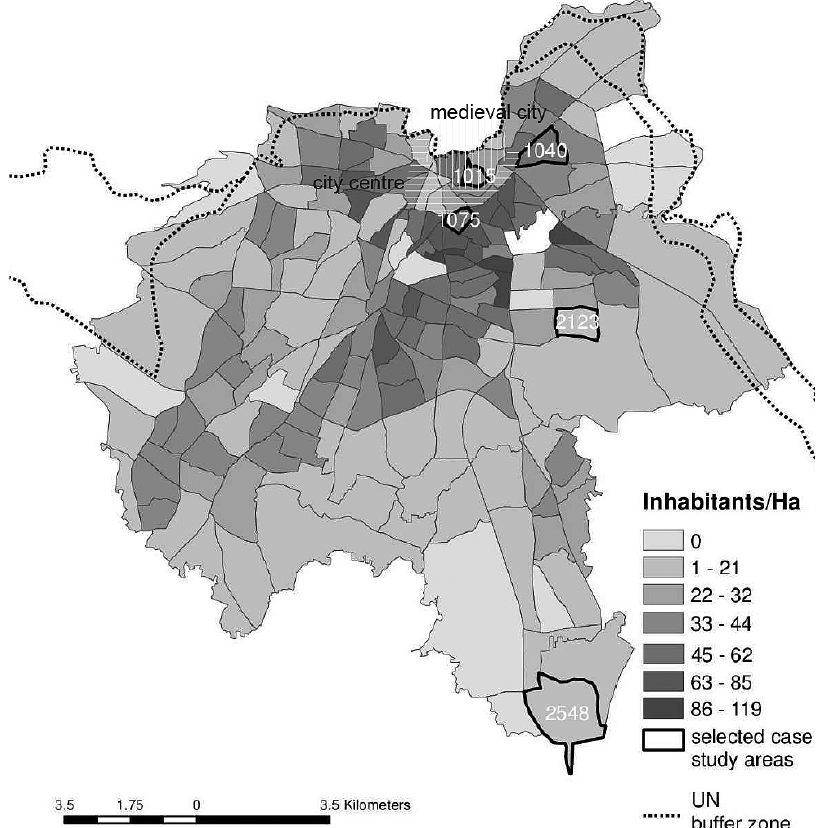
Figure 2. Nicosia postal districts density map. Medieval city: vertical white hatch; city centre: horizontal white